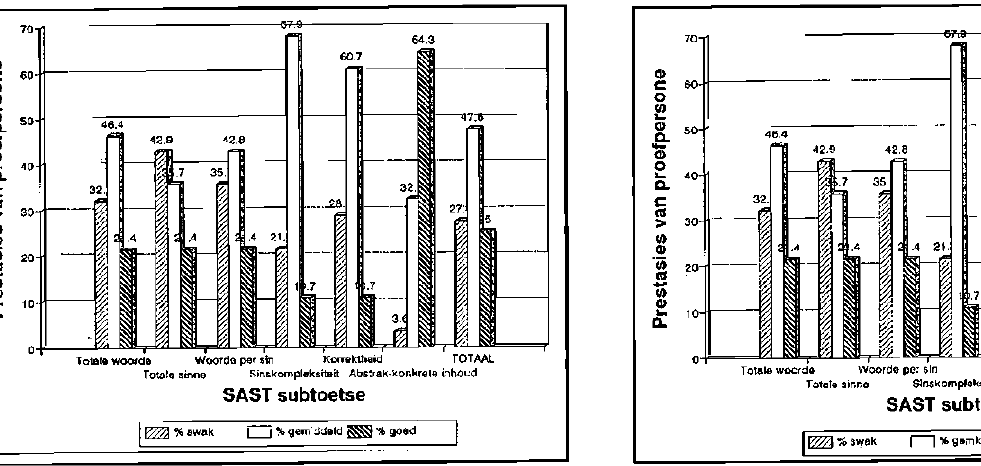
FIGUUR 3: Prestasies van proefpersone in algemene skolastiese